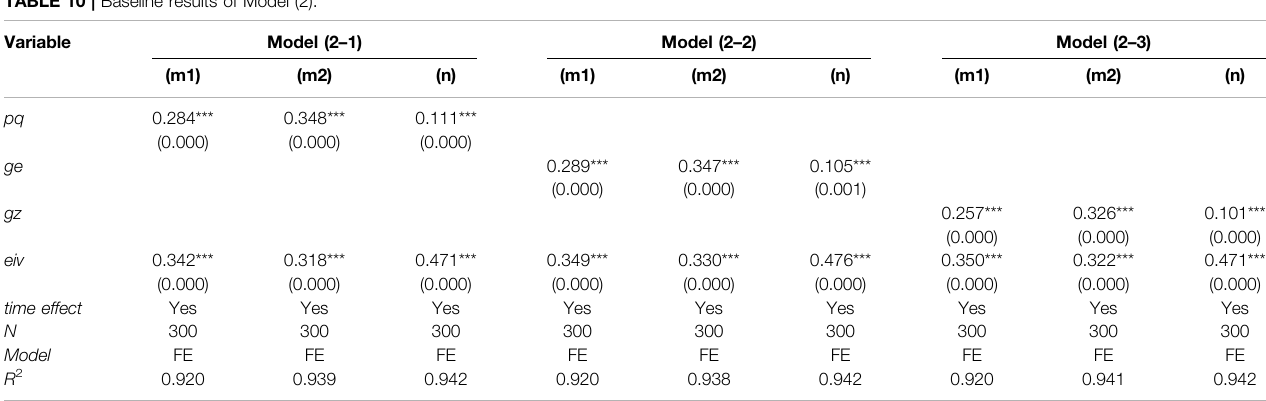
TABLE 10 | Baseline results of Model